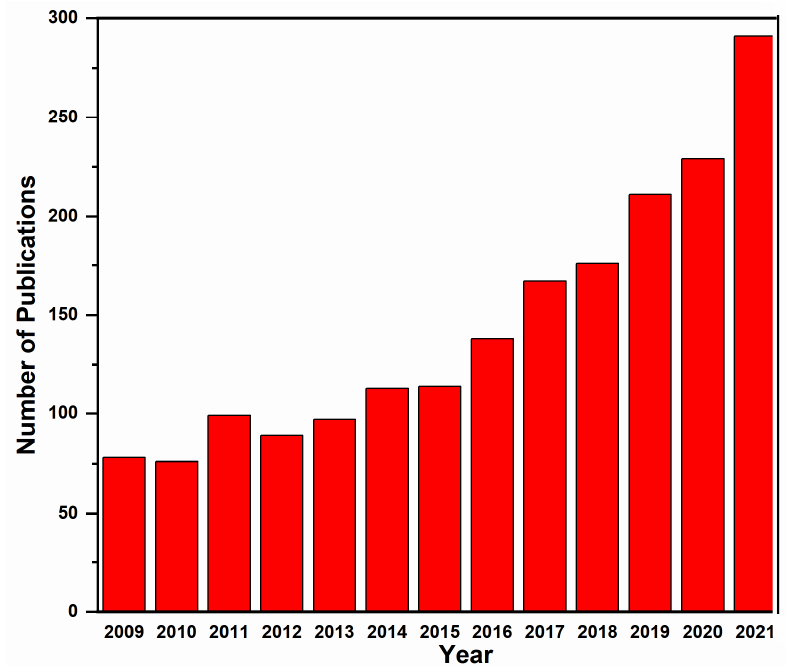
Figure 2. Number of articles published in recent years, Source: Scopus “Arsenic in water” as on 01/07/2021. 1 July